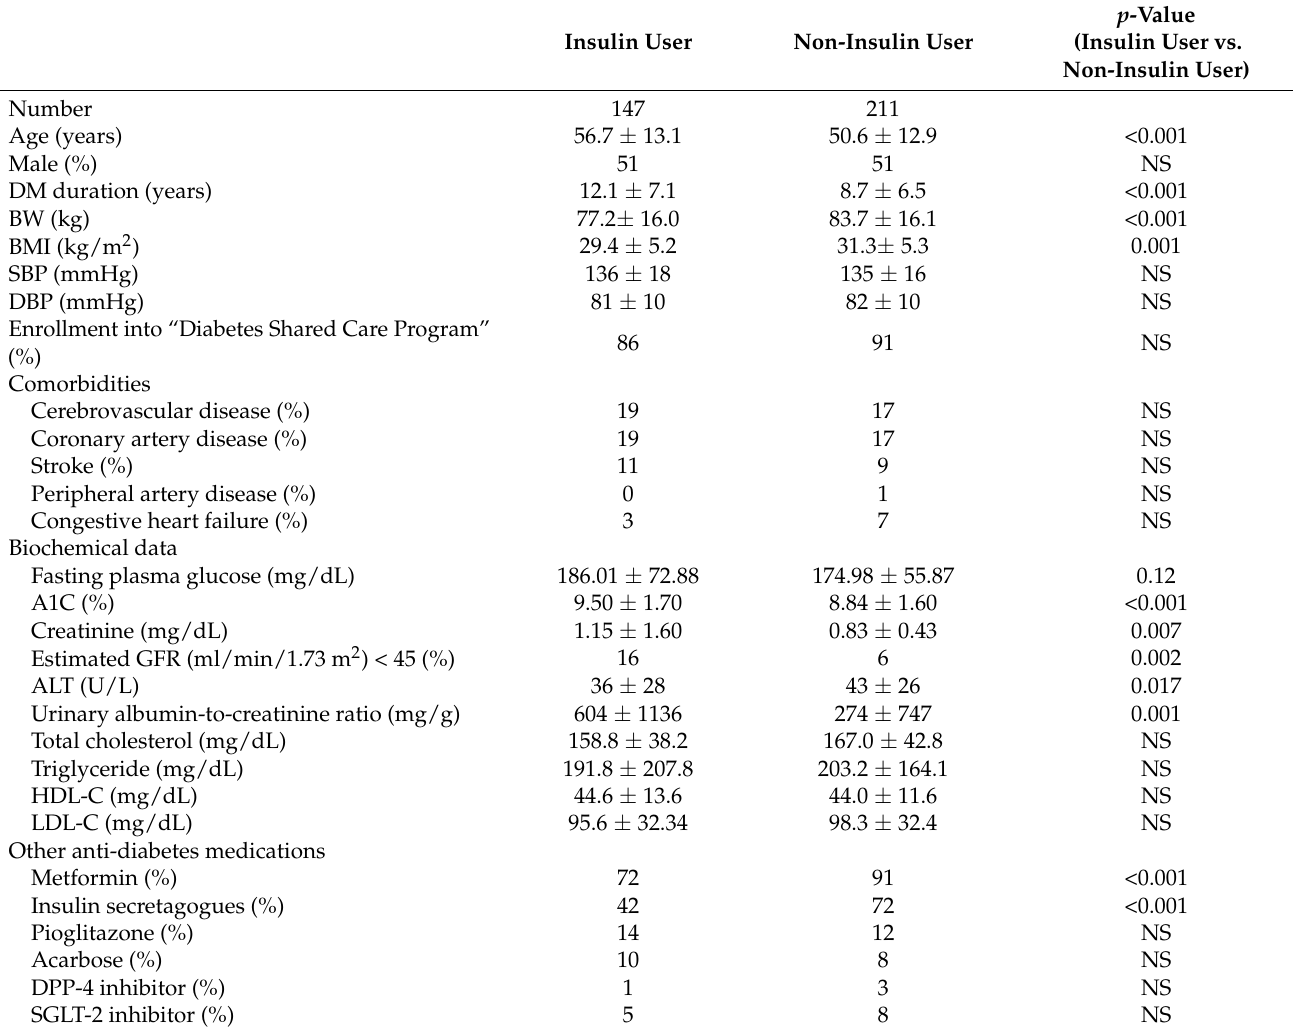
Table 1. Comparisons of baseline clinical parameters between insulin users and non-insulin